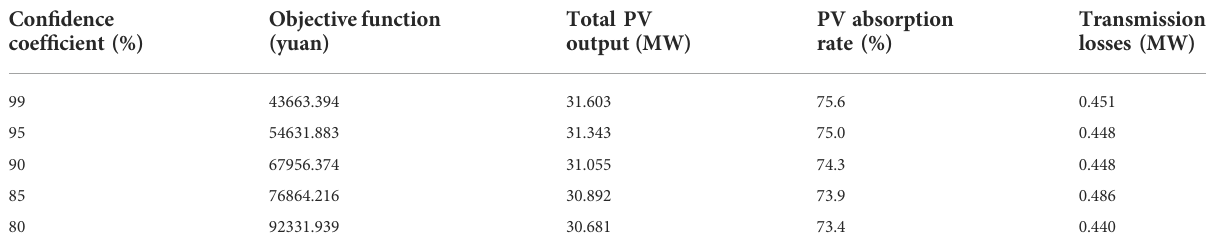
TABLE 5 Results of robust dispatching.